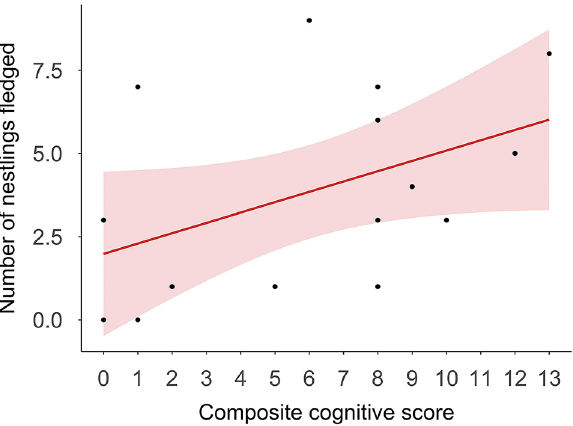
Figure 3. Males with higher composite cognitive score raise more nestlings. Relationship between male composite cognitive score and number of nestlings fledged ( N = 15). Shaded areas represent 95% confidence intervals from the generalized linear